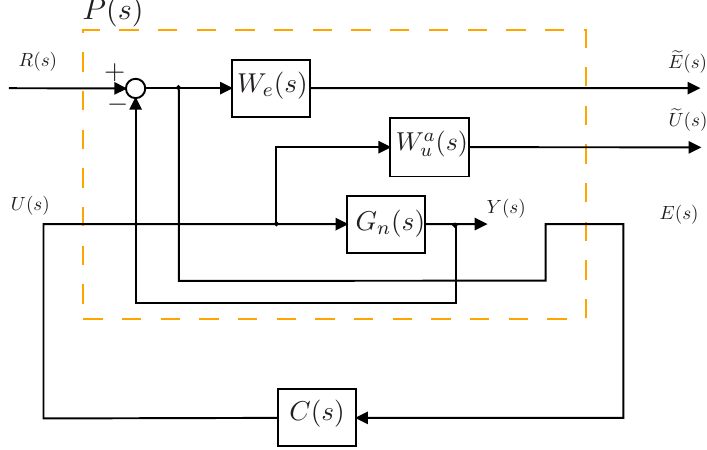
Figure 12. Augmented plant, P ( s ) , and weighted mixed-sensitivity design